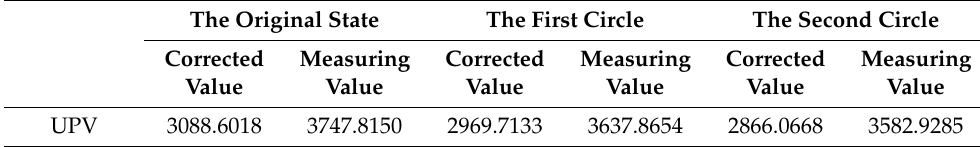
Table 8. The corrected and measuring UPV values of the specimen (m/s).